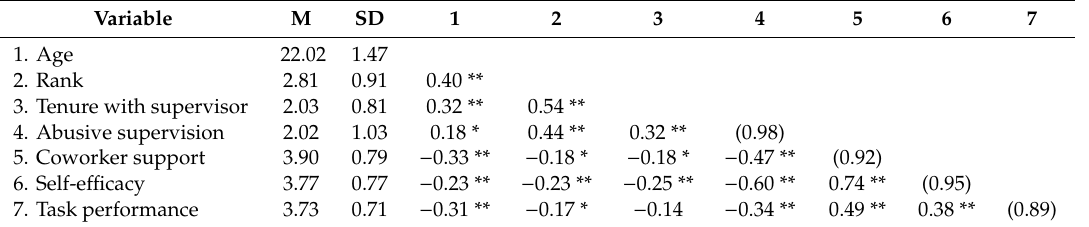
Table 1. Bivariate Correlations and